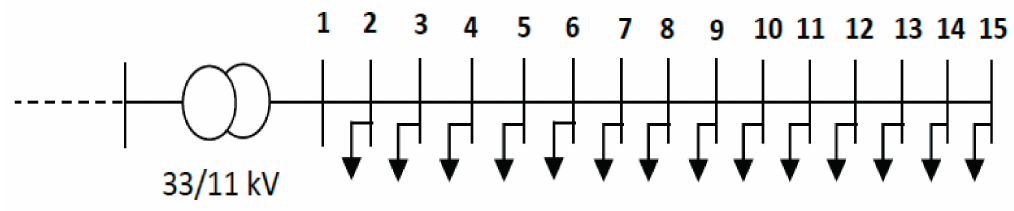
Figure 3. A case study 15-bus distribution network of